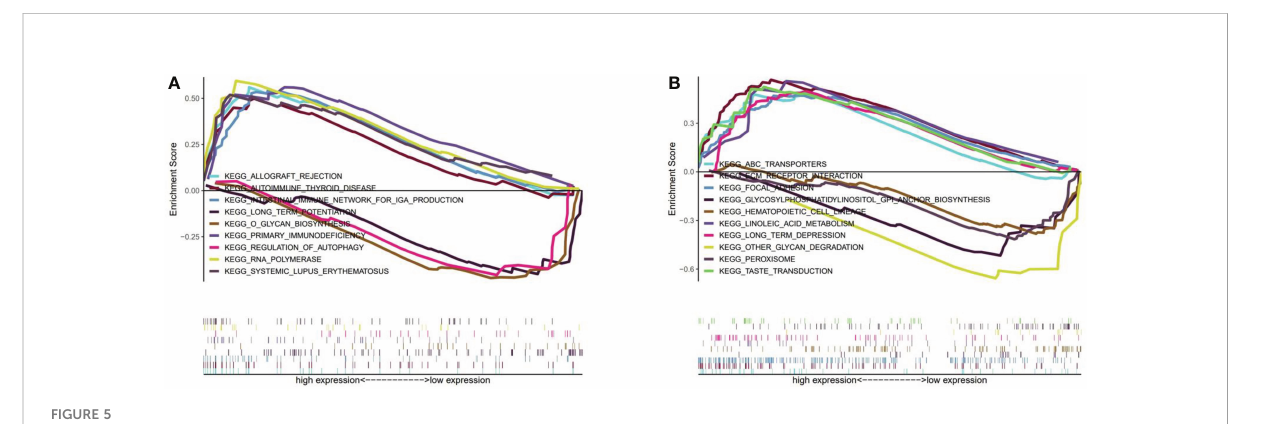
FIGURE 5 (A) GSEA analysis for TP53. (B) GSEA analysis for